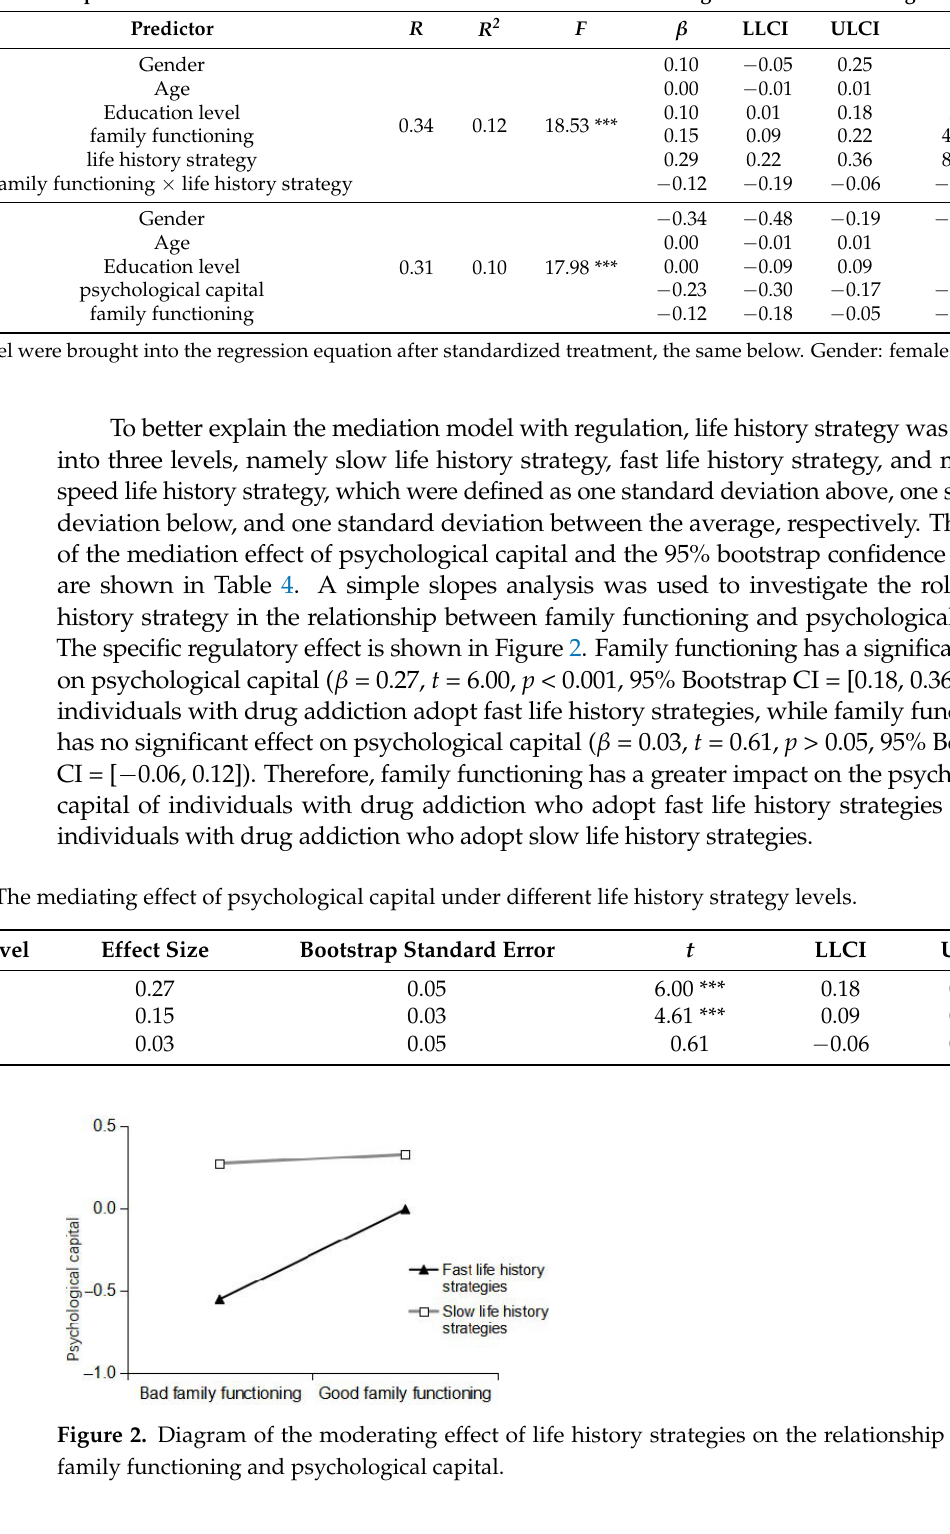
Table 3. Regression Analysis of the mediating role of life history strategies in mediating family functioning and relapse tendency. Regression Equation